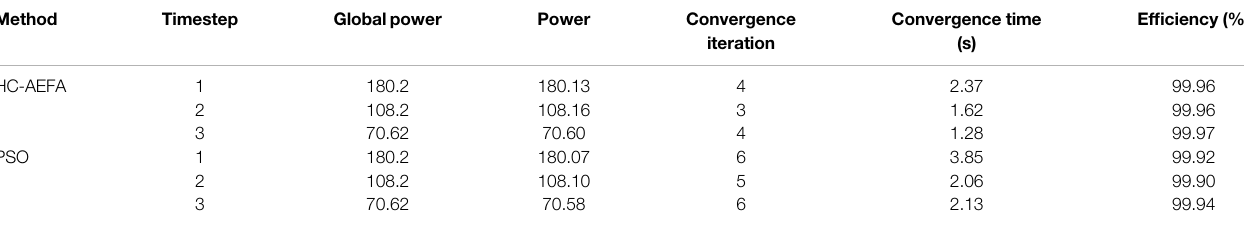
TABLE 5 | Numerical results for the performance of the HC-AEFA and PSO methods in the fourth pattern. Method Timestep